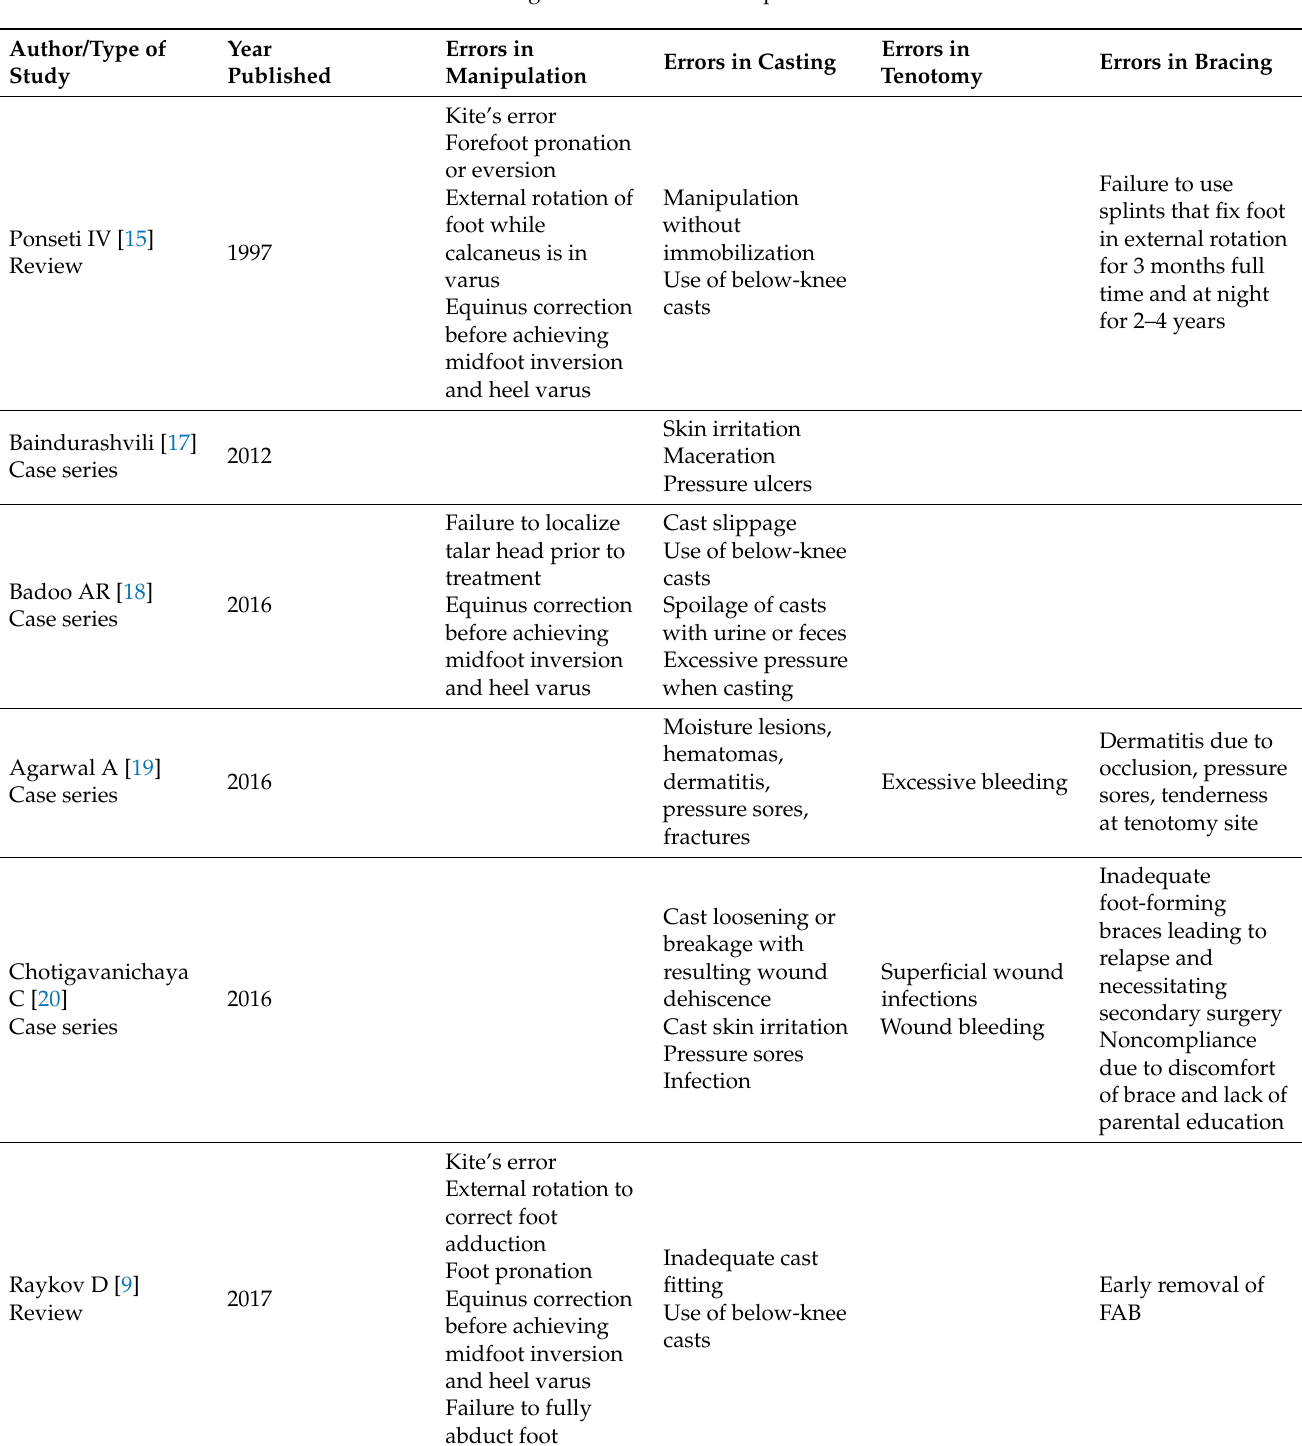
Table 2. Errors during the Ponseti method reported in the